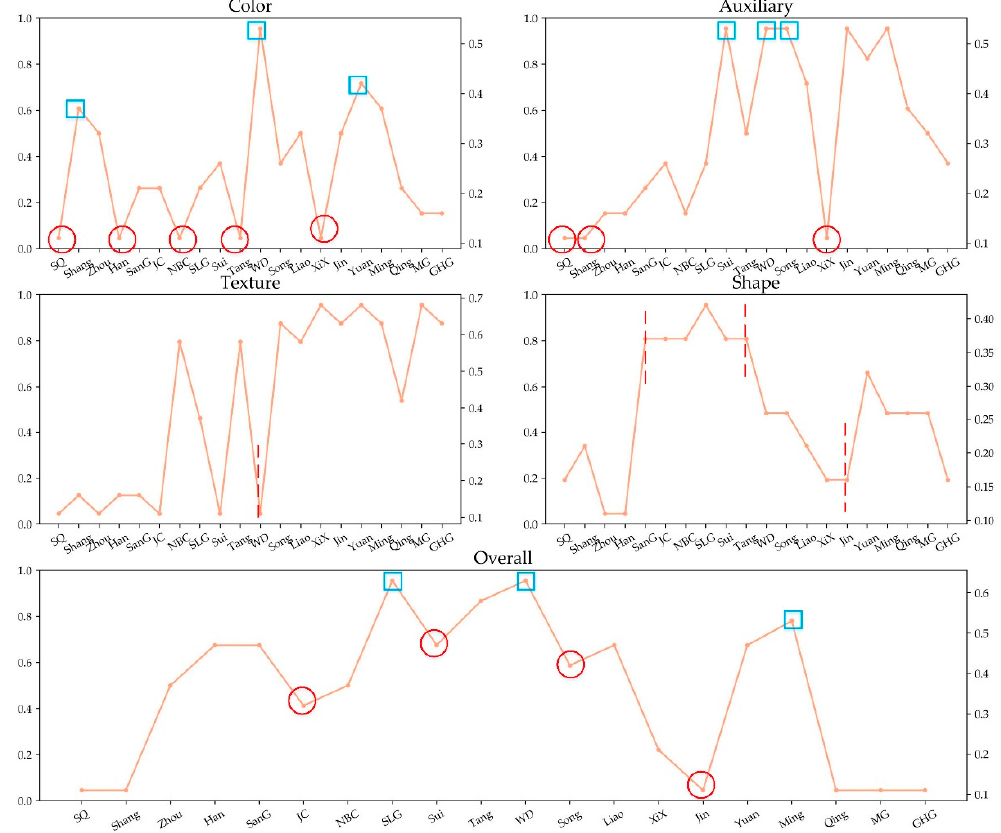
Figure 9. The distribution of centrality for nodes in cultural meme networks.